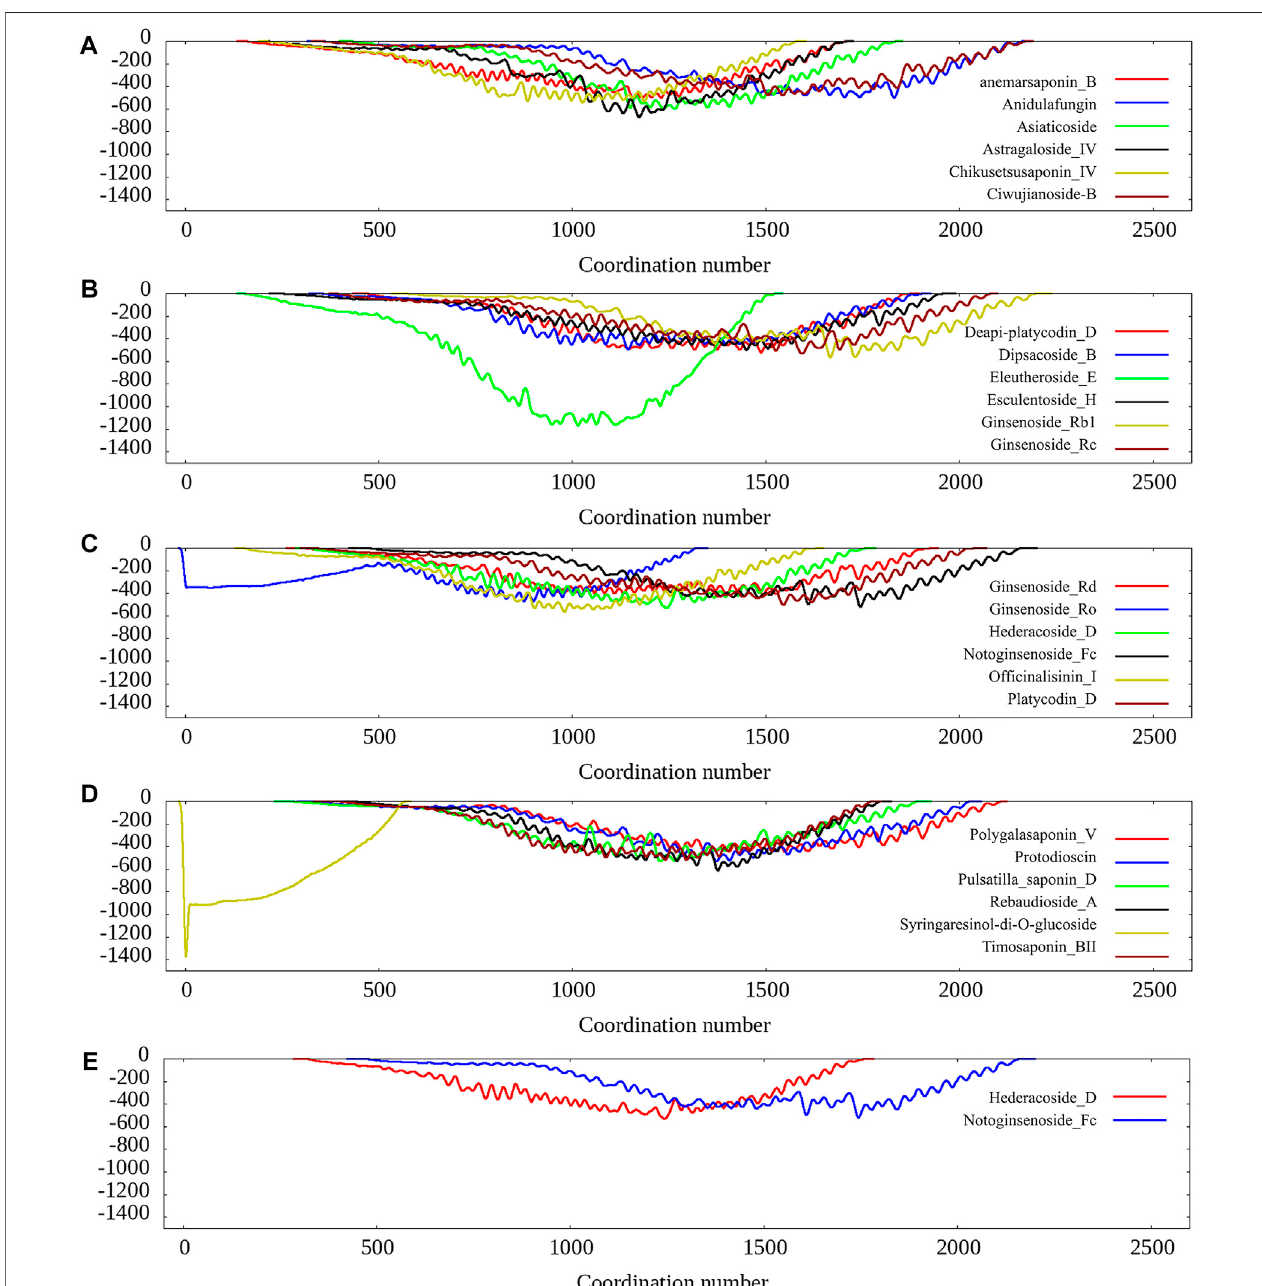
FIGURE 2 | The calculated free energy landscape from the 100 ns metadynamics simulations.